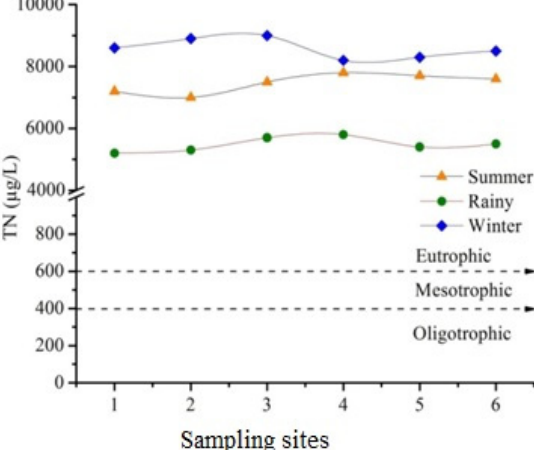
Fig. 4: Seasonal deviations in total nitrogen concentration